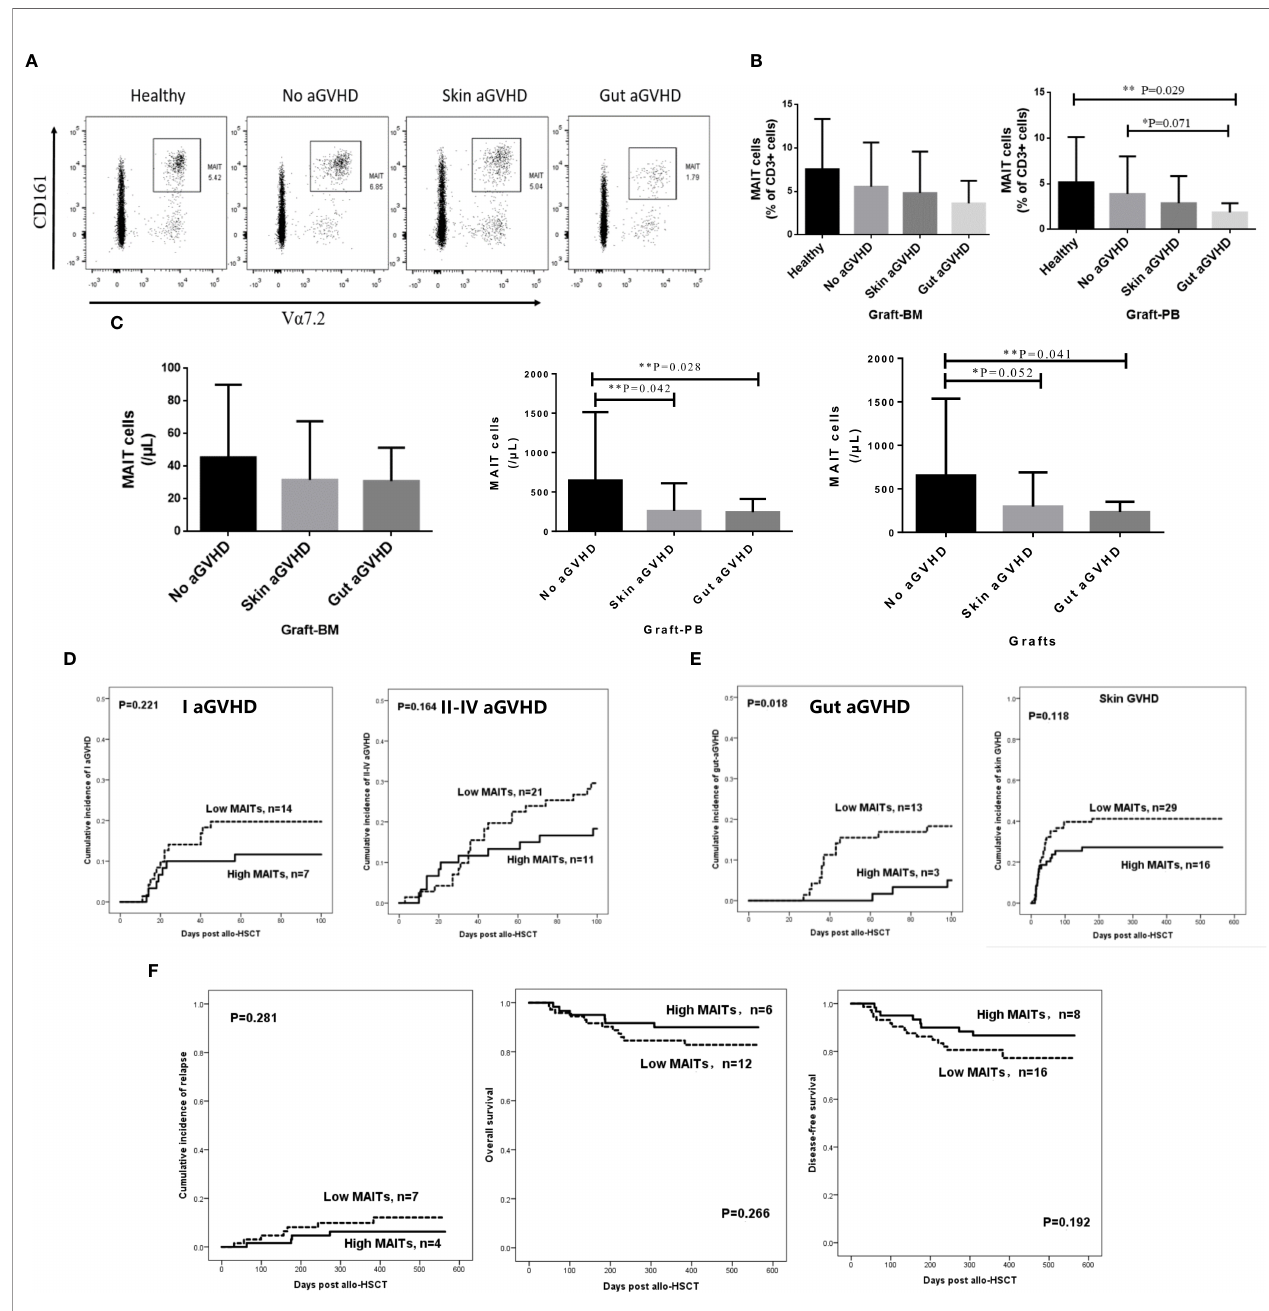
FIGURE 1 | Comparison of the frequency and number of mucosa-associated invariant T (MAIT) cells in the grafts from the recombinant human granulocyte colony- stimulating factor (rhG-CSF) mobilized donors and healthy person. (A) Flow cytometry of MAIT cells in the grafts of four patient groups. (B) The frequency of MAIT cells (% of CD3+ cells) in graft-bone marrow (BM) [Healthy, n = 4; No acute graft-versus-host disease (aGVHD), n = 21; Skin aGVHD, n = 28; Gut aGVHD, n = 12] and graft-peripheral blood (PB) (Healthy, n = 8; No aGVHD, n = 24; Skin aGVHD, n = 27; Gut aGVHD, n = 15; Gut aGVHD vs. Healthy, p = 0.029). (C) The number of MAIT cells in graft-BM, graft-PB (Gut aGVHD vs. no aGVHD, p = 0.028; Skin aGVHD vs. no aGVHD, p = 0.042), and the total grafts (No aGVHD, n = 16; Skin aGVHD, n = 13; Gut aGVHD, n = 13). (D) The in fl uence of the high MAIT (>5.3 × 10 6 /kg) and low MAIT (<5.3 × 10 6 /kg) group level in the graft on the occurrence of aGVHD (I aGVHD and II – IV aGVHD). (E) The in fl uence of the high MAIT (>5.3 × 10 6 /kg) and low MAIT (<5.3×10 6 /kg) groups in infused graft on gut aGVHD (p = 0.018) or skin aGVHD. (F) The in fl uence of the high MAIT (>5.3 × 10 6 /kg) and low MAIT (<5.3 × 10 6 /kg) groups in infused graft on the prognosis after transplantation. Levels of signi fi cances are given as p-values with ** ≤ 0.05 and * ≤